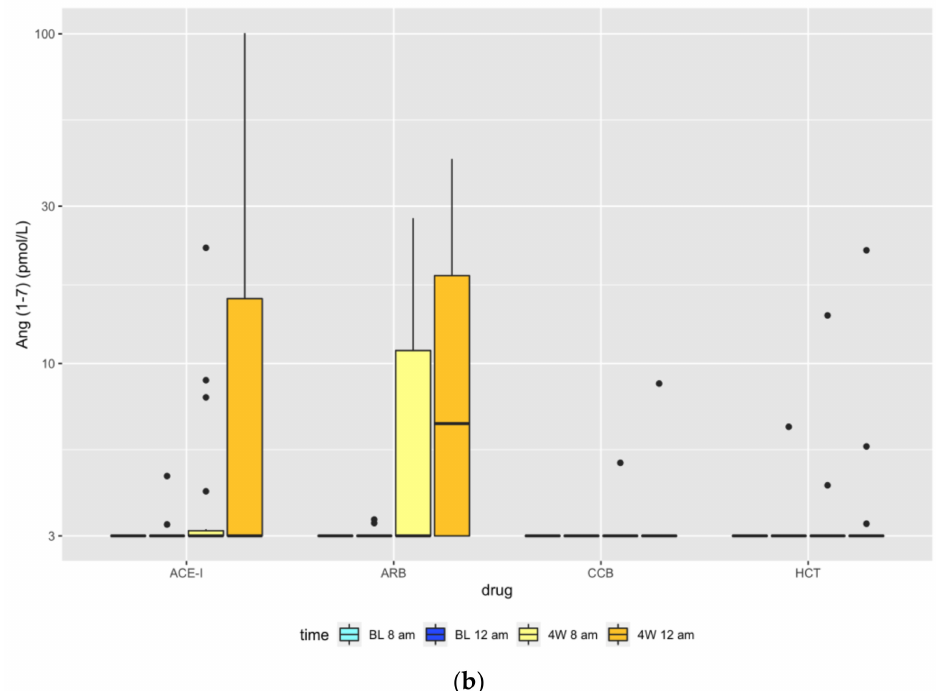
Figure 1. Box plots of Ang II ( a ) and Ang (1–7) ( b ) equilibrium concentrations at baseline (BL) at 8 a.m. (light blue) and 12 a.m. (dark blue), and after four weeks (4W) of treatment at 8 a.m. before drug intake (light yellow) and four hours after observed drug intake (dark yellow). Note: 3 pmol/L is the lower limit of detection for Ang (1–7). Dots correspond to outliers. ACE-I = angiotensin-converting-enzyme inhibitor (perindopril), ARB = angiotensin-receptor blocker (olmesartan), CCB = calcium channel blocker (amlodipine), HCT = hydrochlorothiazide.